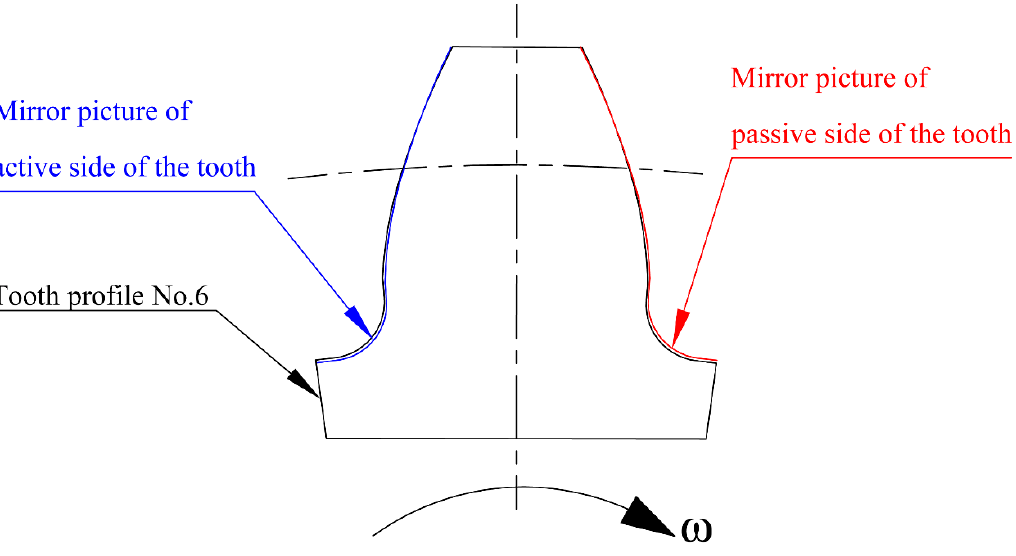
Figure 16. Asymmetry of tooth No. 6.